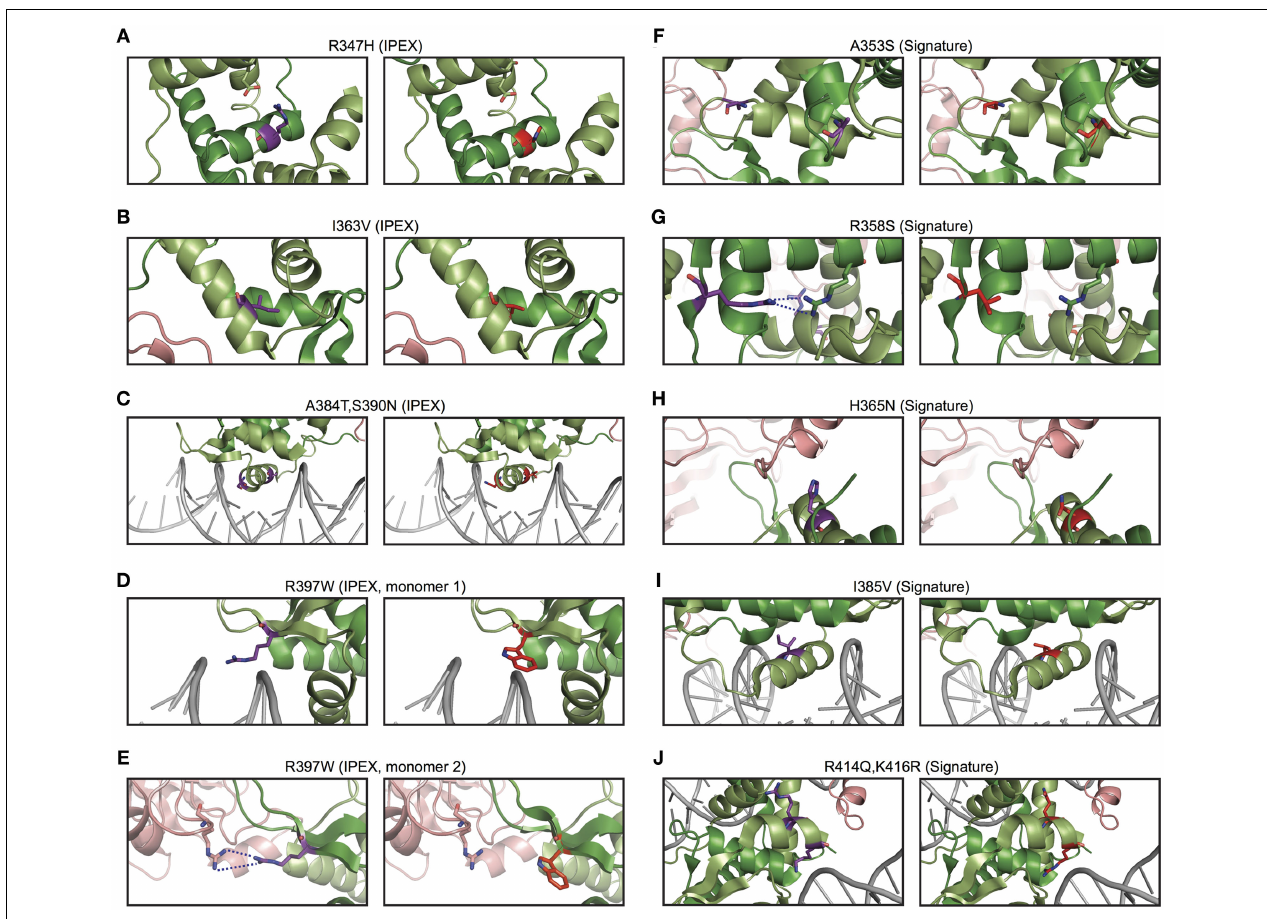
FIGURE 9 |The predicted effects of point mutations in the Foxp3 forkhead. (A–E) IPEX point mutants in Foxp3 (right) with the corresponding wildtype residue (left). (F–J) Foxp3-specific signature residues (left) compared to the Foxp consensus (right).